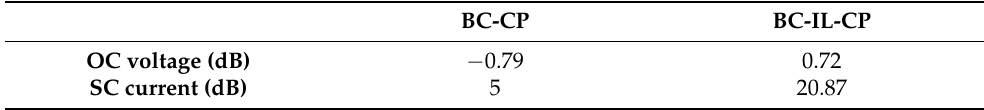
Table 1. SINAD Values for BC-Based Composites.